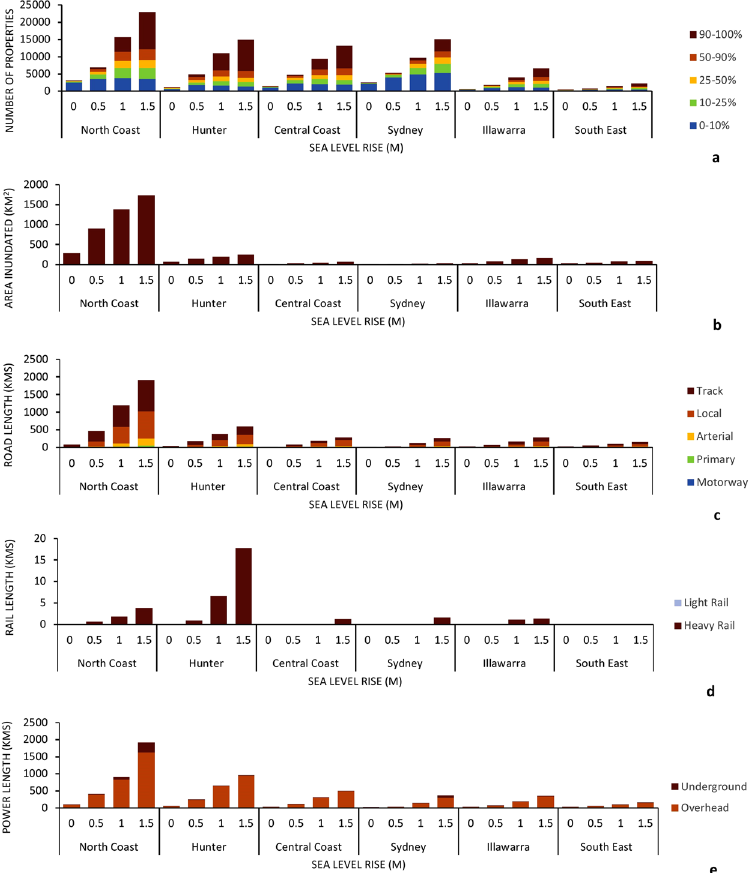
Figure 4. Regional spread in exposure results including. ( a ) Total numbers of properties exposed to inundation (HHWSS or berm level) under 0 m, 0.5 m, 1.0 m and 1.5 m sea level rise scenarios including the proportion of property land area inundated (0–10%, 10–25%, 25–50%, 50–90% and 90–100%); ( b ) overall area inundated (HHWSS or berm level) under 0 m, 0.5 m, 1.0 m and 1.5 m sea level rise scenarios; ( c ) length of road exposed to inundation (HHWSS or berm level) under 0 m, 0.5 m, 1.0 m and 1.5 m sea level rise scenarios including road type (track, local, arterial, primary or motorway); ( d ) length of rail track exposed to inundation (HHWSS or berm level) under 0 m, 0.5 m, 1.0 m and 1.5 m sea level rise scenarios including track type (light, heavy); ( e ) length of power line exposed to inundation (HHWSS or berm level) under 0 m, 0.5 m, 1.0 m and 1.5 m sea level rise scenarios including line type (underground,